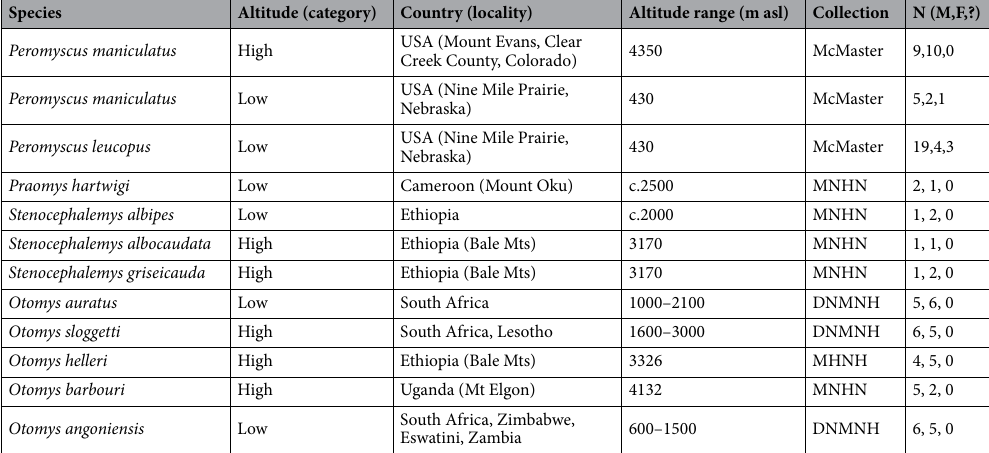
Table 1. Details of samples used in the study. The question mark (?) represent individuals of unknown sex, meters above sea level (m asl).